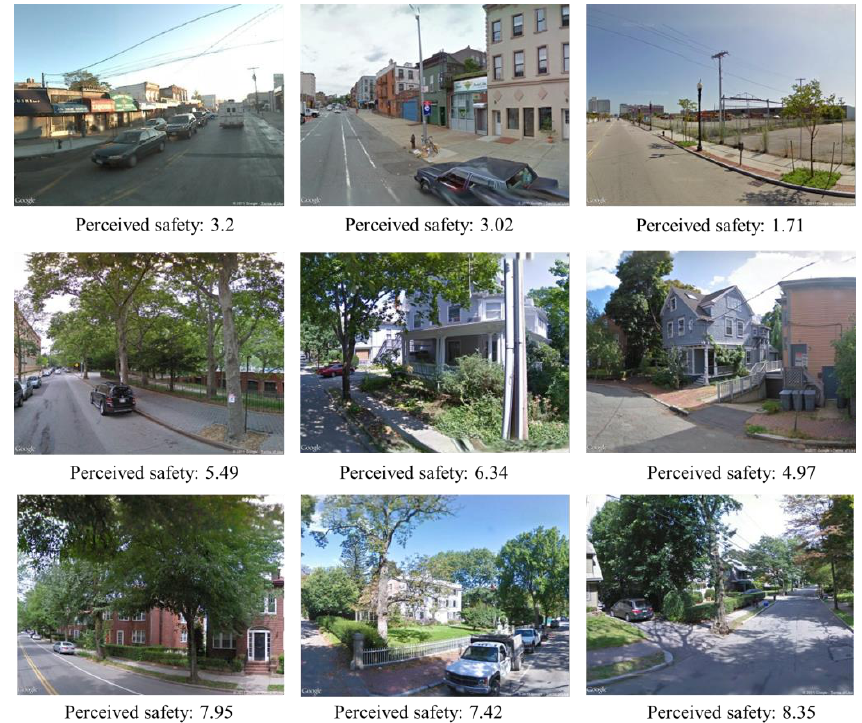
Figure 2 . GSV images from Place Pulse 1.0 datasets and corresponding perceived safety